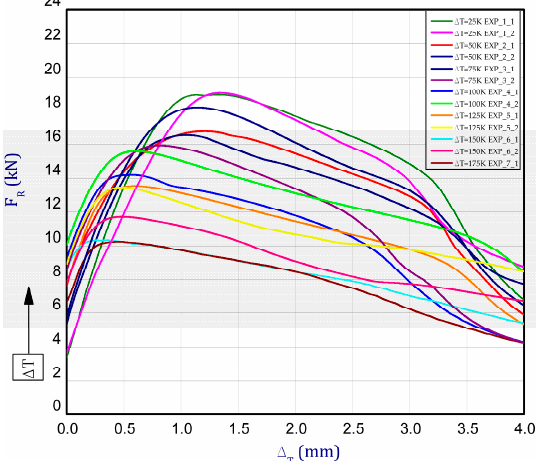
Figure 8. The reaction force vs. shortening of column for several temperature increases.